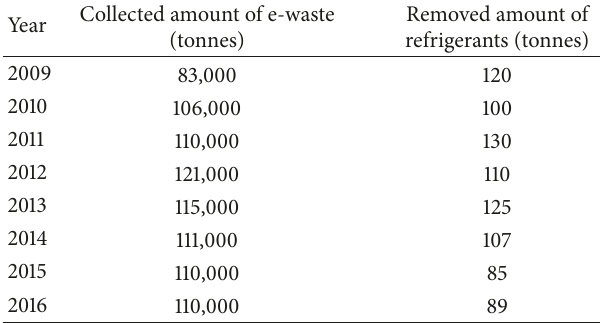
Table 2: Quantities collected e-waste per year, and the amount of refrigerants removed from cooling and freezing appliances in an environmentally responsible